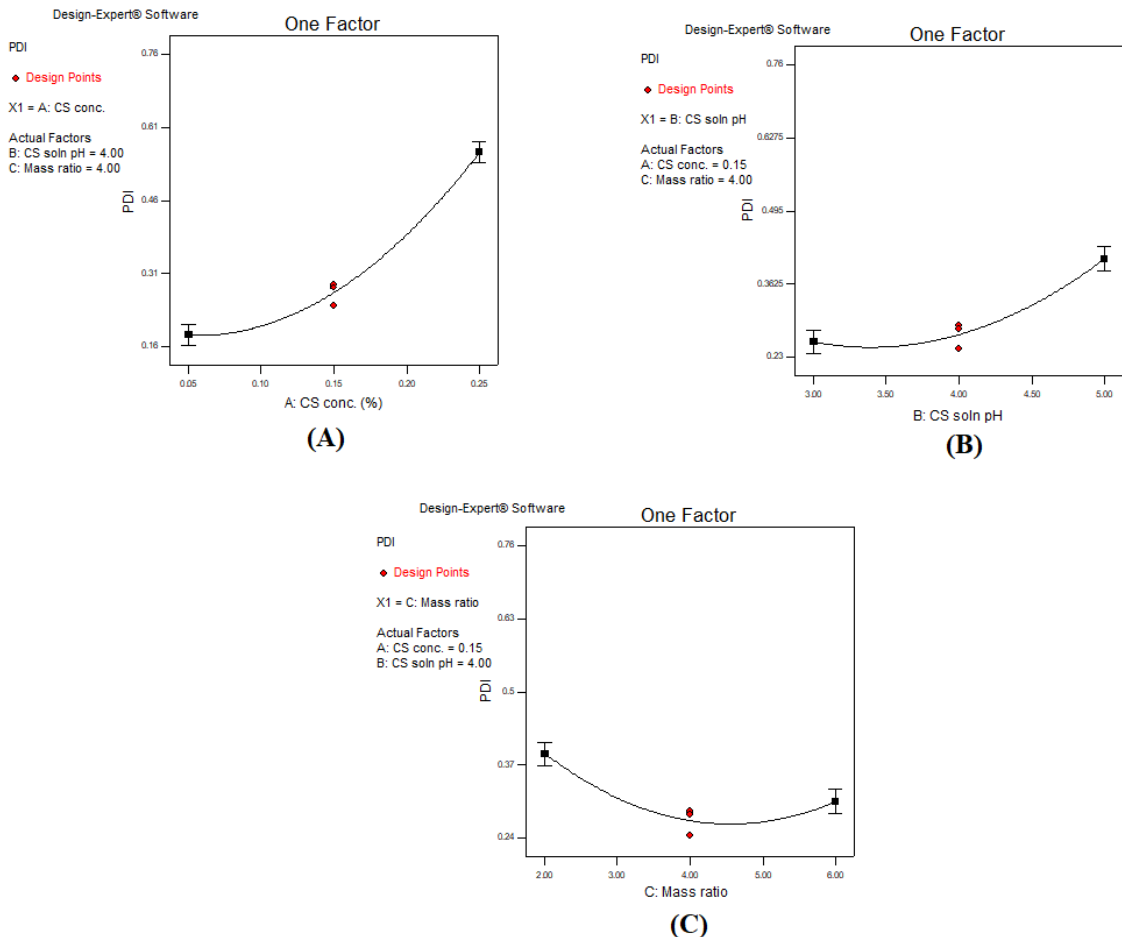
Figure 3. One factor line plot of the main effect of ( A ) CS concentration, ( B ) CS solution pH, and ( C ) CS:TPP mass ratio on the PDI.